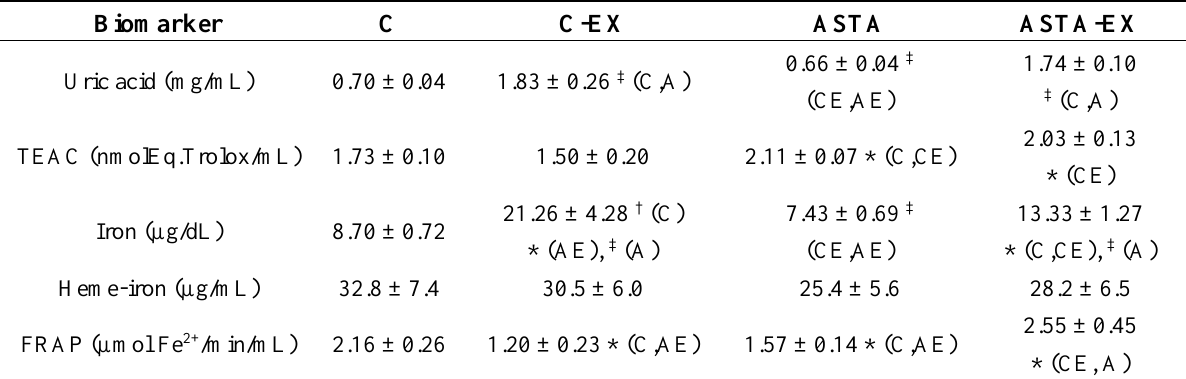
Table 2. Oxidative stress biomarkers in plasma of rested or exhausted Wistar rats supplemented for 45 days with 1 mg ASTA/kg BW (ASTA and ASTA-EX, respectively for rested and exhausted animals) or mineral oil (C and C-EX). Biomarker C C-EX ASTA